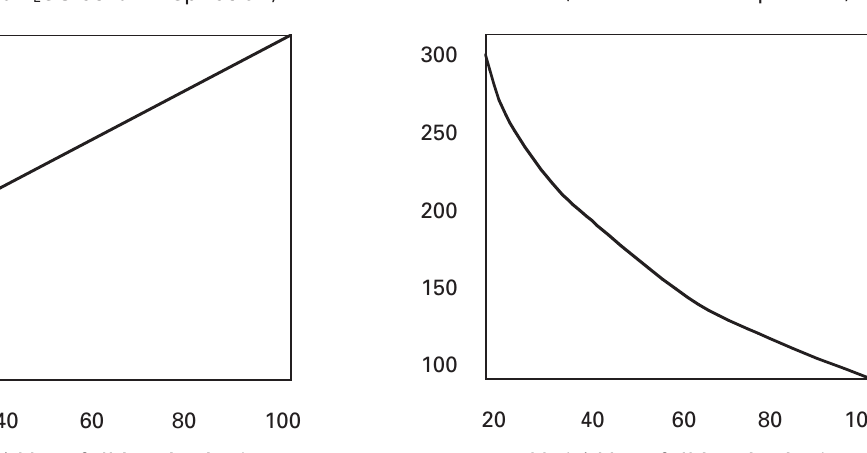
Figure 1 Variation of carbon monoxide transfer coefficient (KCO) and transfer factor (TLCO) with lung expansion in normal subjects. The KCO, T L CO and alveolar volume (V A ) are expressed in per- cent of values mea- sured at full inspira- tion. The KCO in- creases exponentially with decreasing V A . As a result, T L CO decreases only mildly with decreasing V A